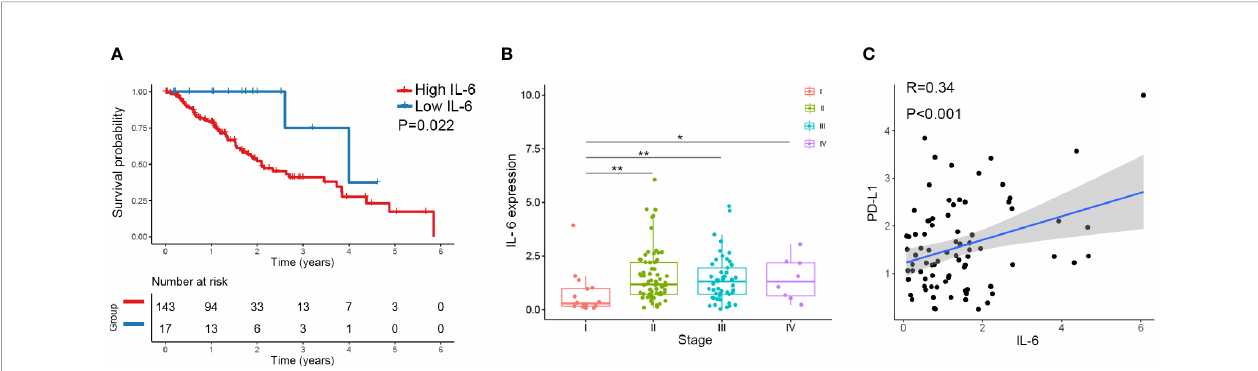
FIGURE 1 | The expression of IL-6 and PD-L1 in esophageal cancer tissues was analyzed by TCGA database. (A) The overall survival probability of patients with high IL-6 expression was signi fi cantly lower than that of patients with low IL-6 expression. (B) IL-6 expression was signi fi cantly decreased in low-stage tissues compared with higher-stage tissues. (C) PD-L1 was positively correlated with IL-6 expression in esophageal cancer. *p < 0.05, **p <